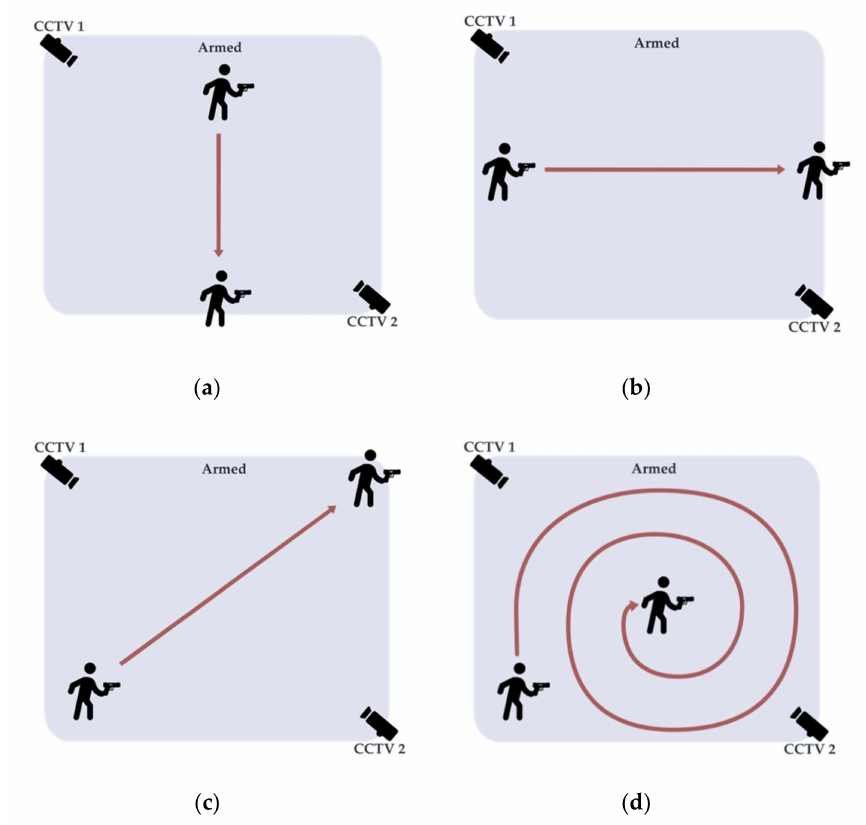
Figure 4. Scenarios where the offender runs out of the frame in three directions: ( a ) left to right, ( b ) top to bottom, ( c ) bottom left to top right, and remains in frame in ( d ) the spiral pattern. The location of data collection for the camera setup was composed of four different areas around the Faculty of Engineering to create different backgrounds, different lighting between indoors and outdoors, and lighting at different times of the day, thus creating a variety of CCTV image characteristics that were suitable for weapon detection, as shown in Figure 5. The CCTV cameras were in standby mode to record the overall mocking scenarios of carrying a pistol or knife during the permitted duration. The overall duration for usable data collection took 2 h 18 min and 2 s using the two cameras, and each location had to be set up to collect both pistol and knife armed scenarios, as shown in Table